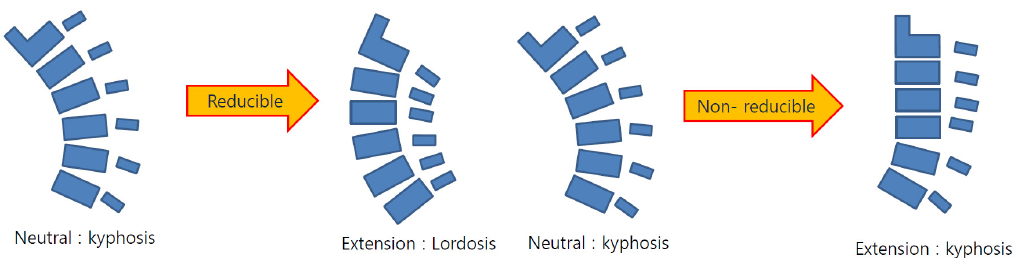
Figure 4. Diagram of reducible non-lordosis and non-reducible non-lordosis. Reducible, non-lordosis switches to lordosis in extension; non-reducible, non-lordosis (or kyphosis) maintains a non-lordotic (or kyphotic) alignment in extension.